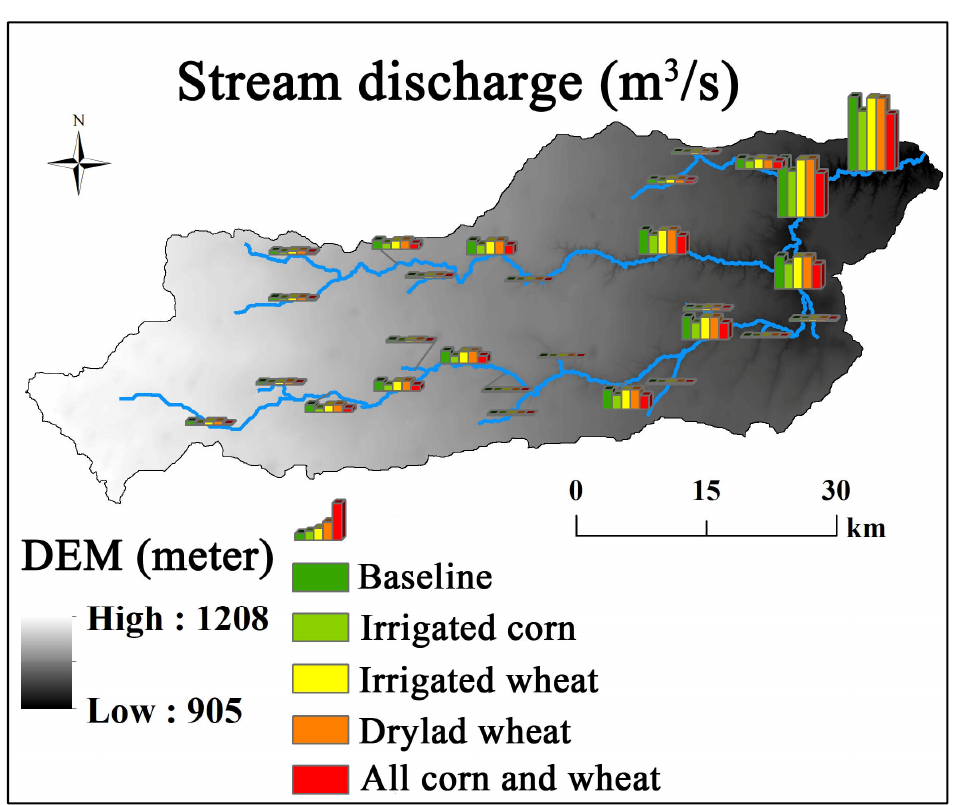
Figure 3. The spatial distribution of simulated surface runoff under cotton land-use change scenarios in the Palo Duro watershed.